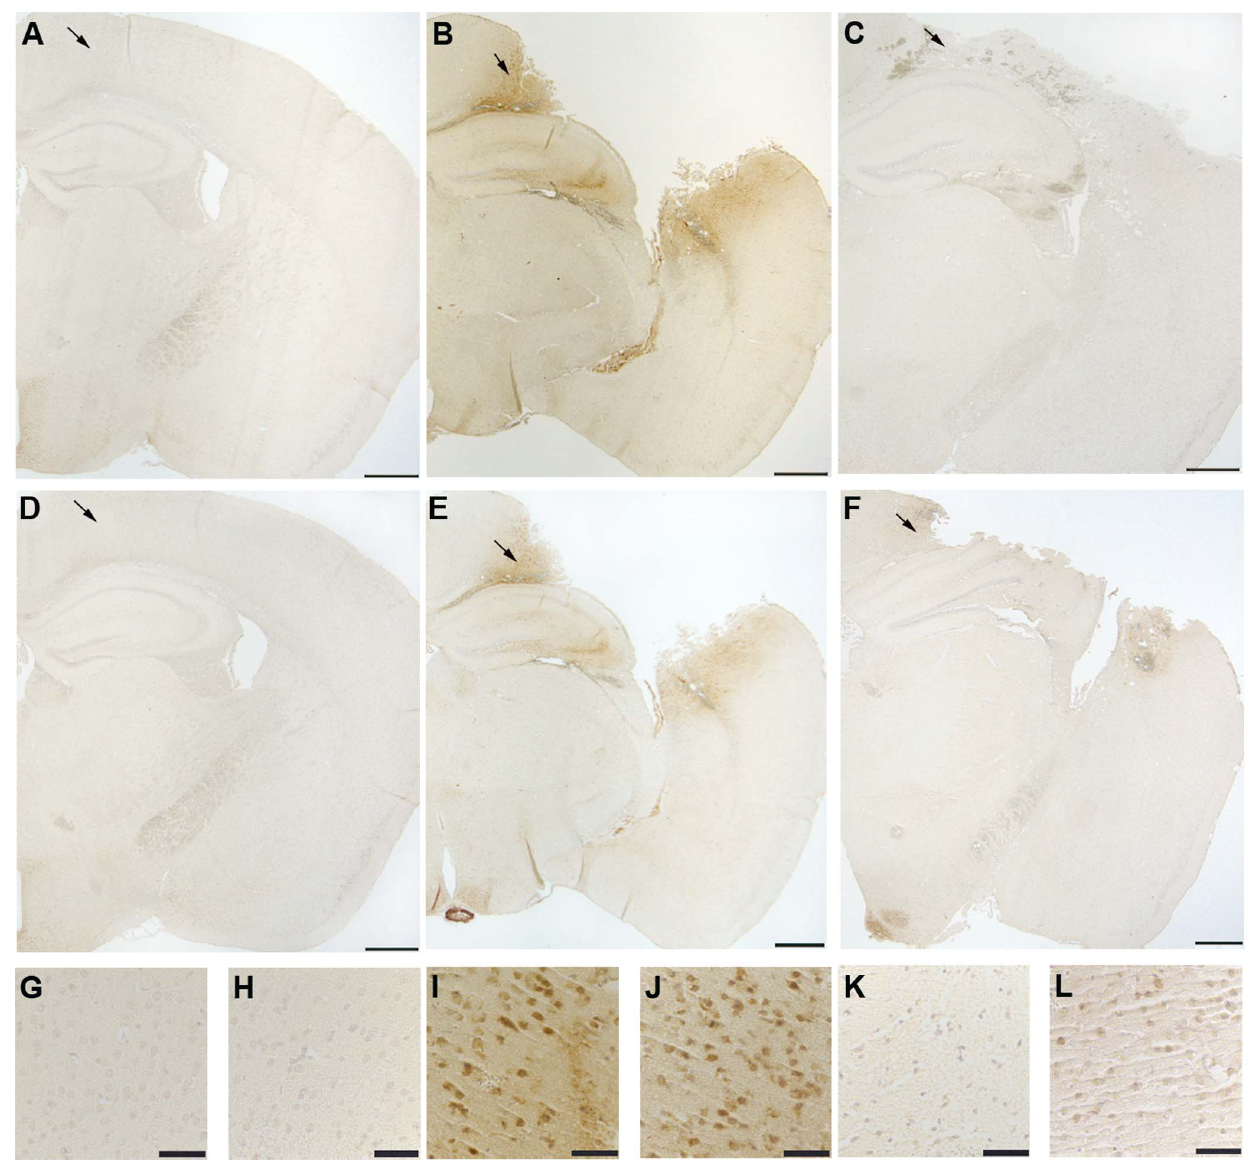
Figure 2. Reduction of CCI-induced pathological tau expression in hippocampus and cortex by mHW. The CCI-induced increase in AT8 and Alz50 immunoreactivity is attenuated by treatment with hydrogen water. Representative images of immunostaining in brains from sham (A, D, G, H), CCI (B, E, I, J), and CCI + mHW treated (C, F, K, L) animals. Low power representative images depict AT8 (A–C) and Alz50 (D–F) immunoreactivity. G– L, high power images of the cortical region designated by arrows, immunostained for AT8 (G,I,K) and Alz50 (H, J, L). Scale bars: 500 m m, A–F; 50 m